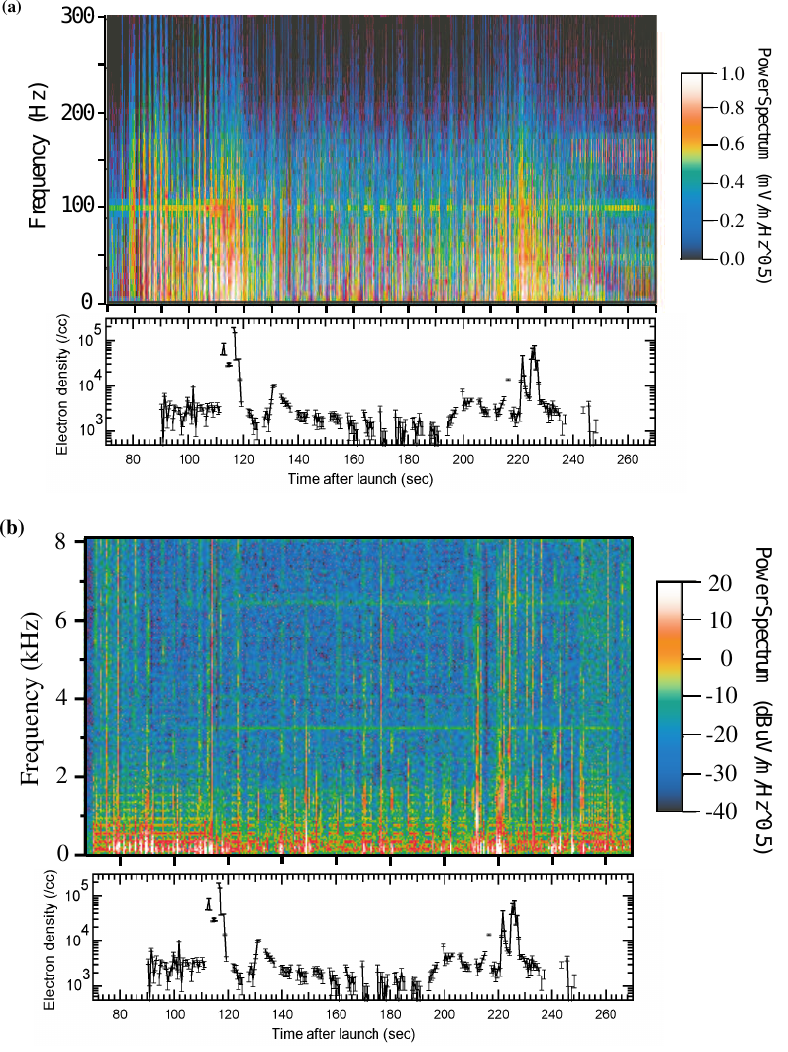
Fig. 6. (a) Dynamic spectrum of PWM1 (lower frequency) and its correspondence to the E s layer structure. (b) Same figures of PWM2 (higher frequency) as in Fig.